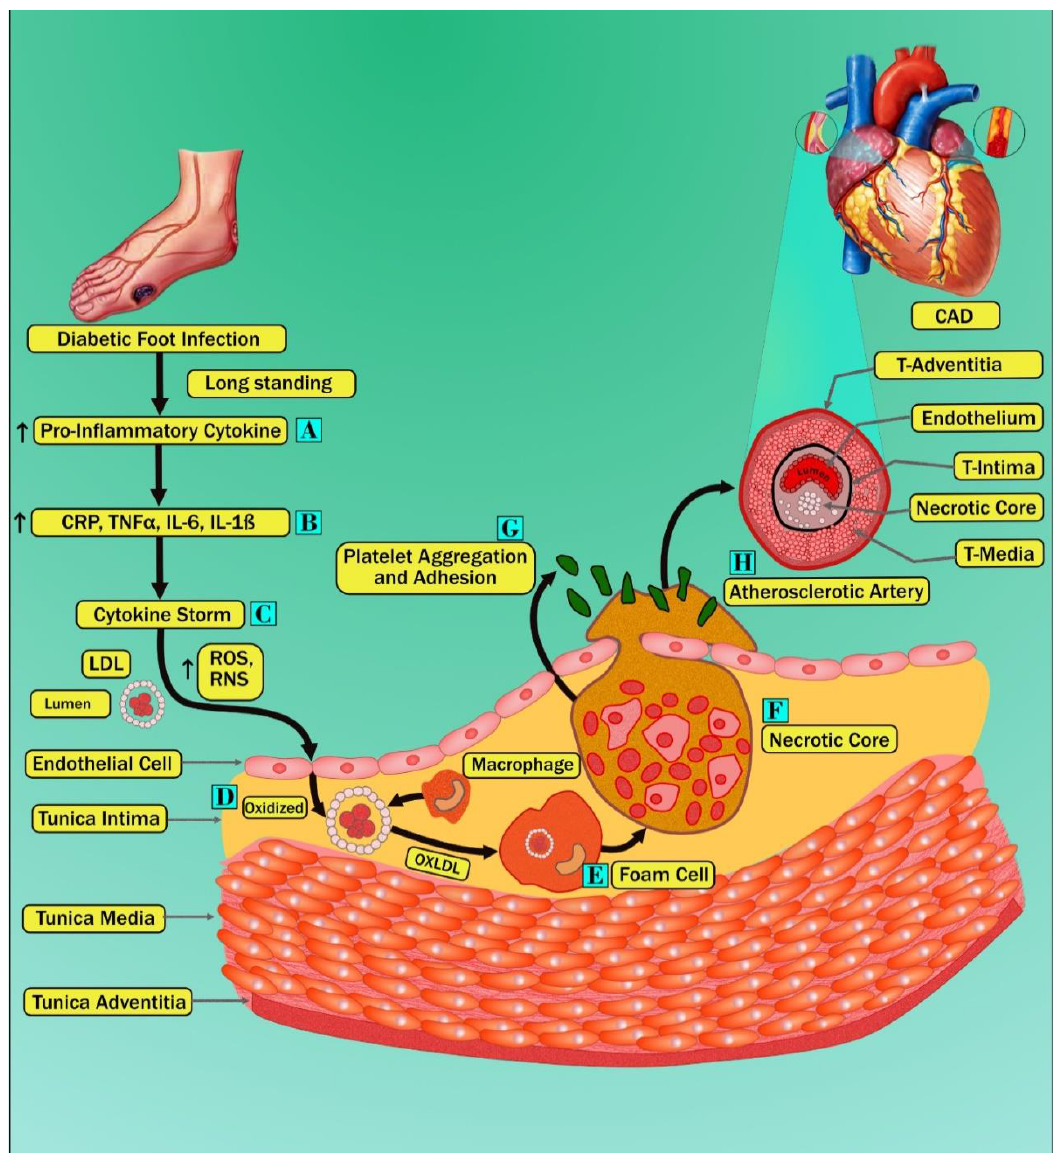
Figure 3. Pathobiological mechanisms of diabetes mellitus, cardiovascular disease, and diabetic foot are shown by different stages marked as A – H. As altered gene expression patterns and signaling pathways combine with immune cells, blood vessel cells malfunction, increasing the risk of vascular and cardiovascular disease in patients with certain metabolic abnormalities